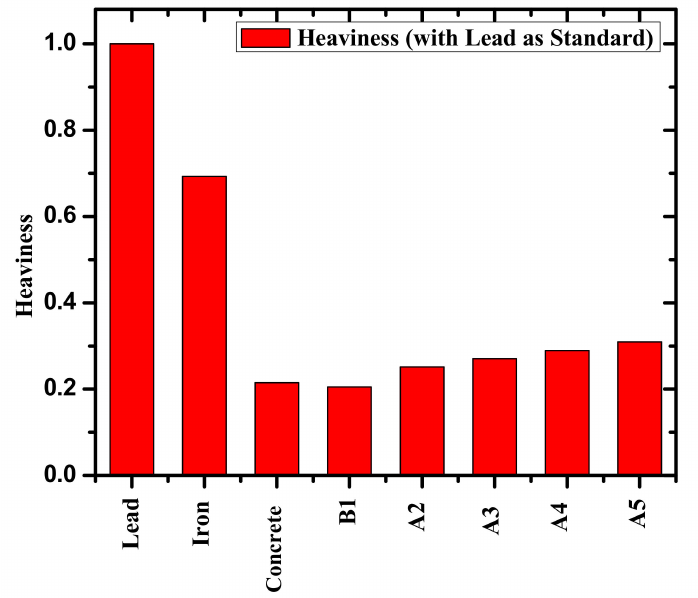
Figure 9. Comparison of heaviness of the present glasses with lead, iron, and concrete.